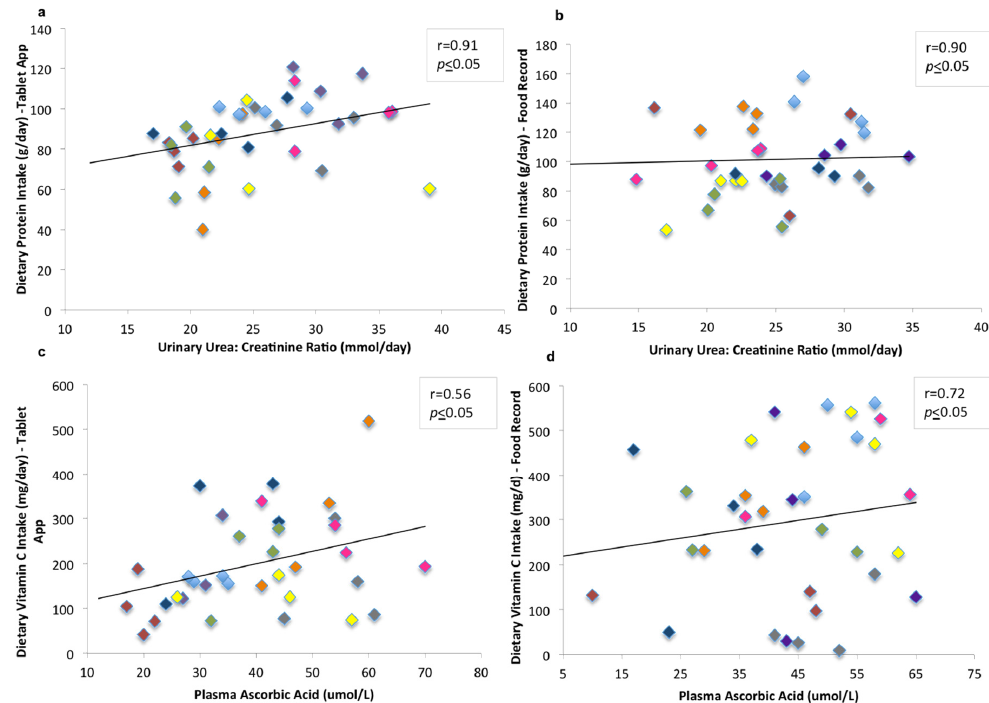
Figure 3. Scatter plots of the relationship between ( a , c ) urinary urea:creatinine ratio and dietary protein intake and between ( b , d ) plasma ascorbic acid and dietary vitamin C intake recorded by the ( a , b ) tablet app and by ( c , d ) wFR. The correlations are examined using multiple regression for repeated measurements and are adjusted for age, body mass index, and energy intake. Data presented is for dietary intake (two days averaged per week for four weeks = four days) and urinary and blood biomarkers (four collections) per participant. The four sets of colors represent individual